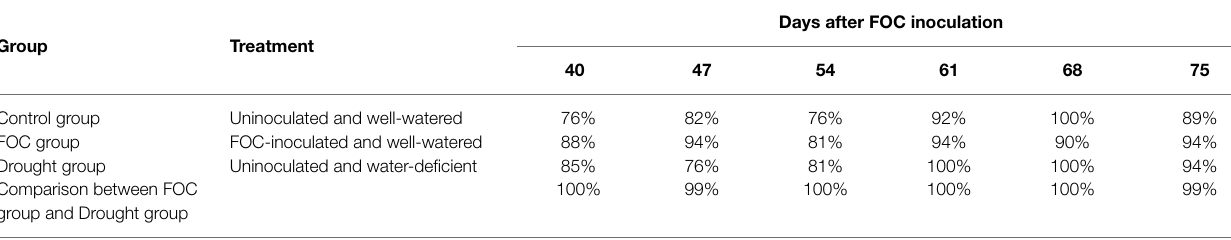
TABLE 1 | Accuracy of binary models for determining three groups of banana plants.